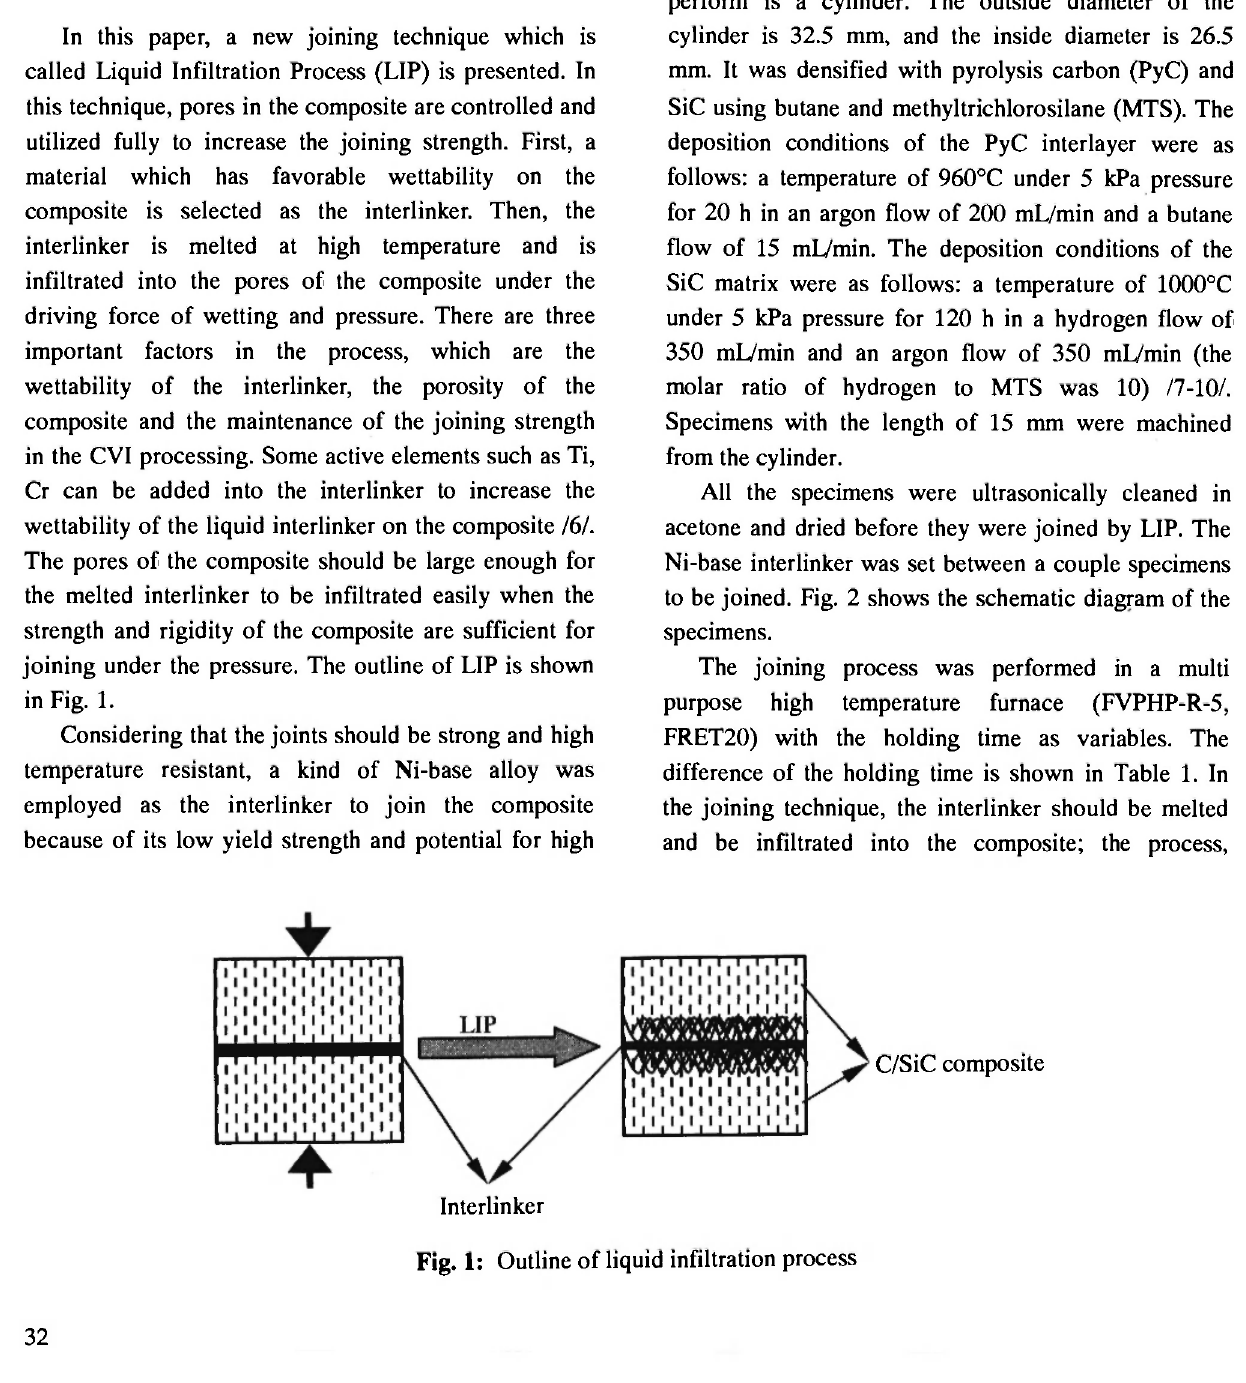
Fig. 1: Outline of liquid infiltration